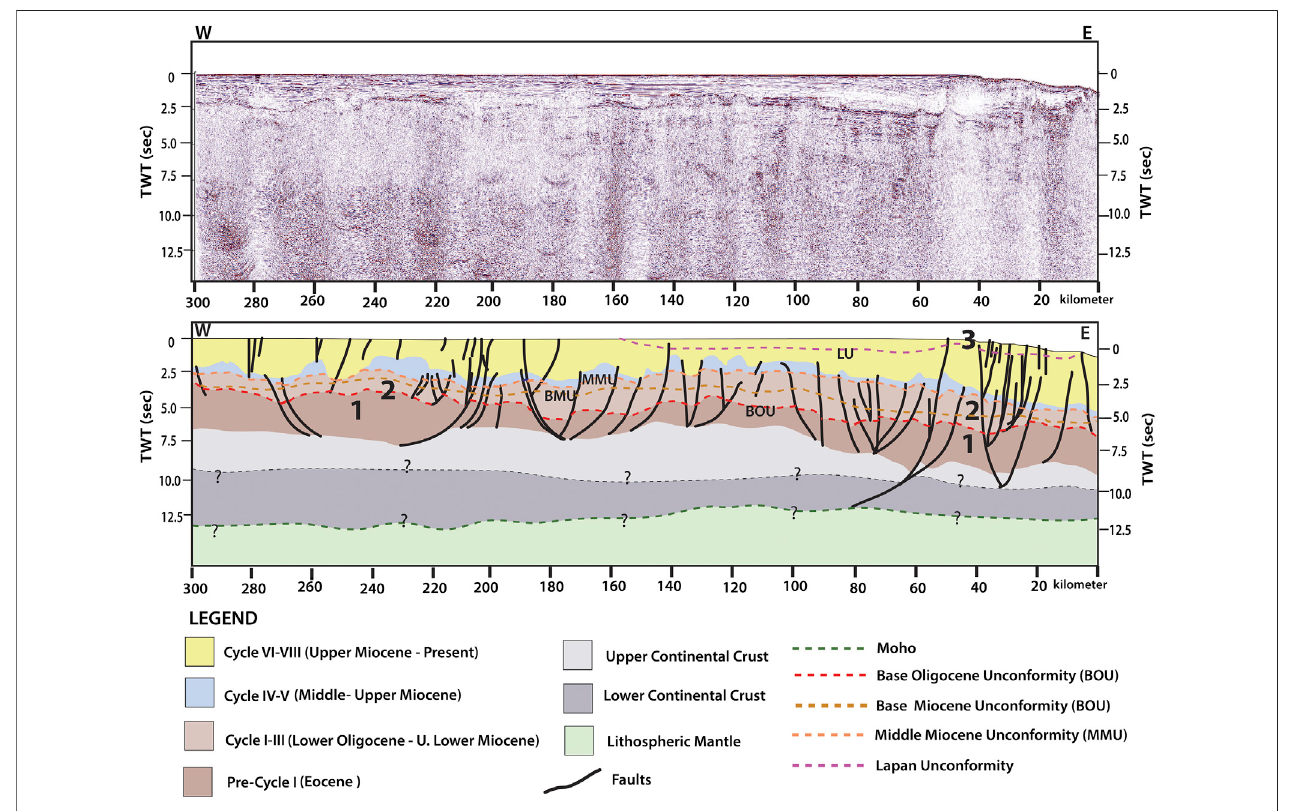
FIGURE 5 | Uninterpreted and interpreted seismic line across E-W of Luconia Province. The western part has thicker crust compared to eastern side. More high angle normal faults are seen in the eastern section within Cycle VI – VIII sequences. Location of the line is shown in Figure 1B . The numbering 1 – 3 are corresponding to the tectonic events discussed in this